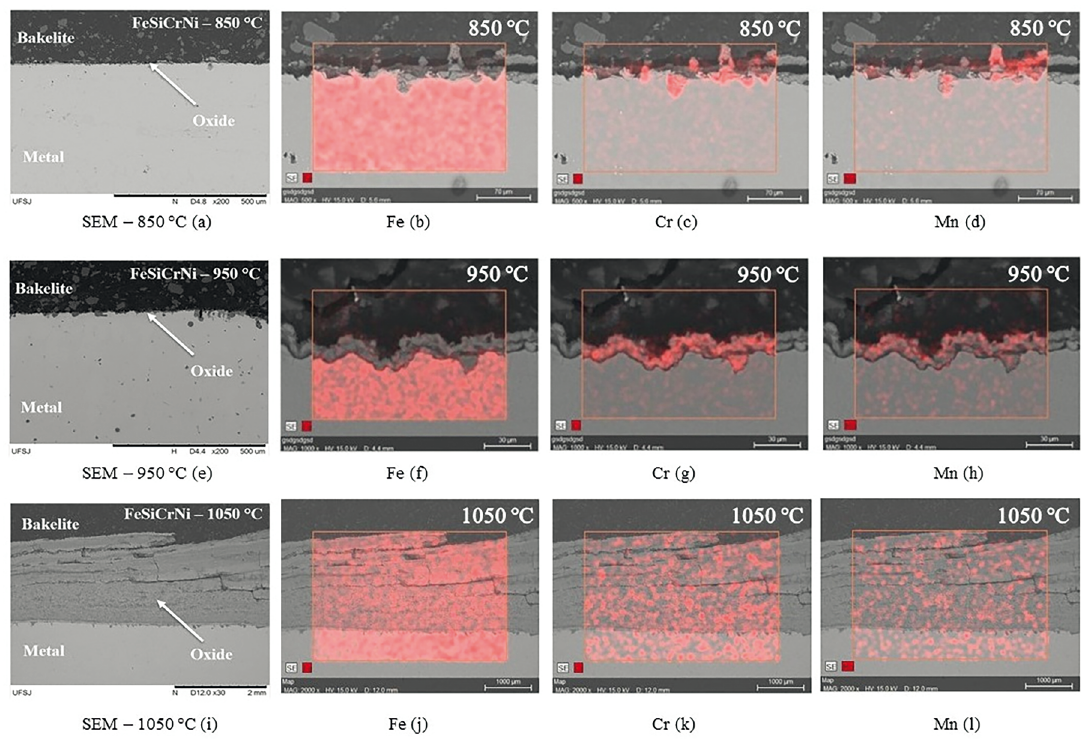
Figure 4. SEM/EDS of cross section of the FeSiCrNi alloy after cyclic oxidation at 850, 950 and 1050 ºC.